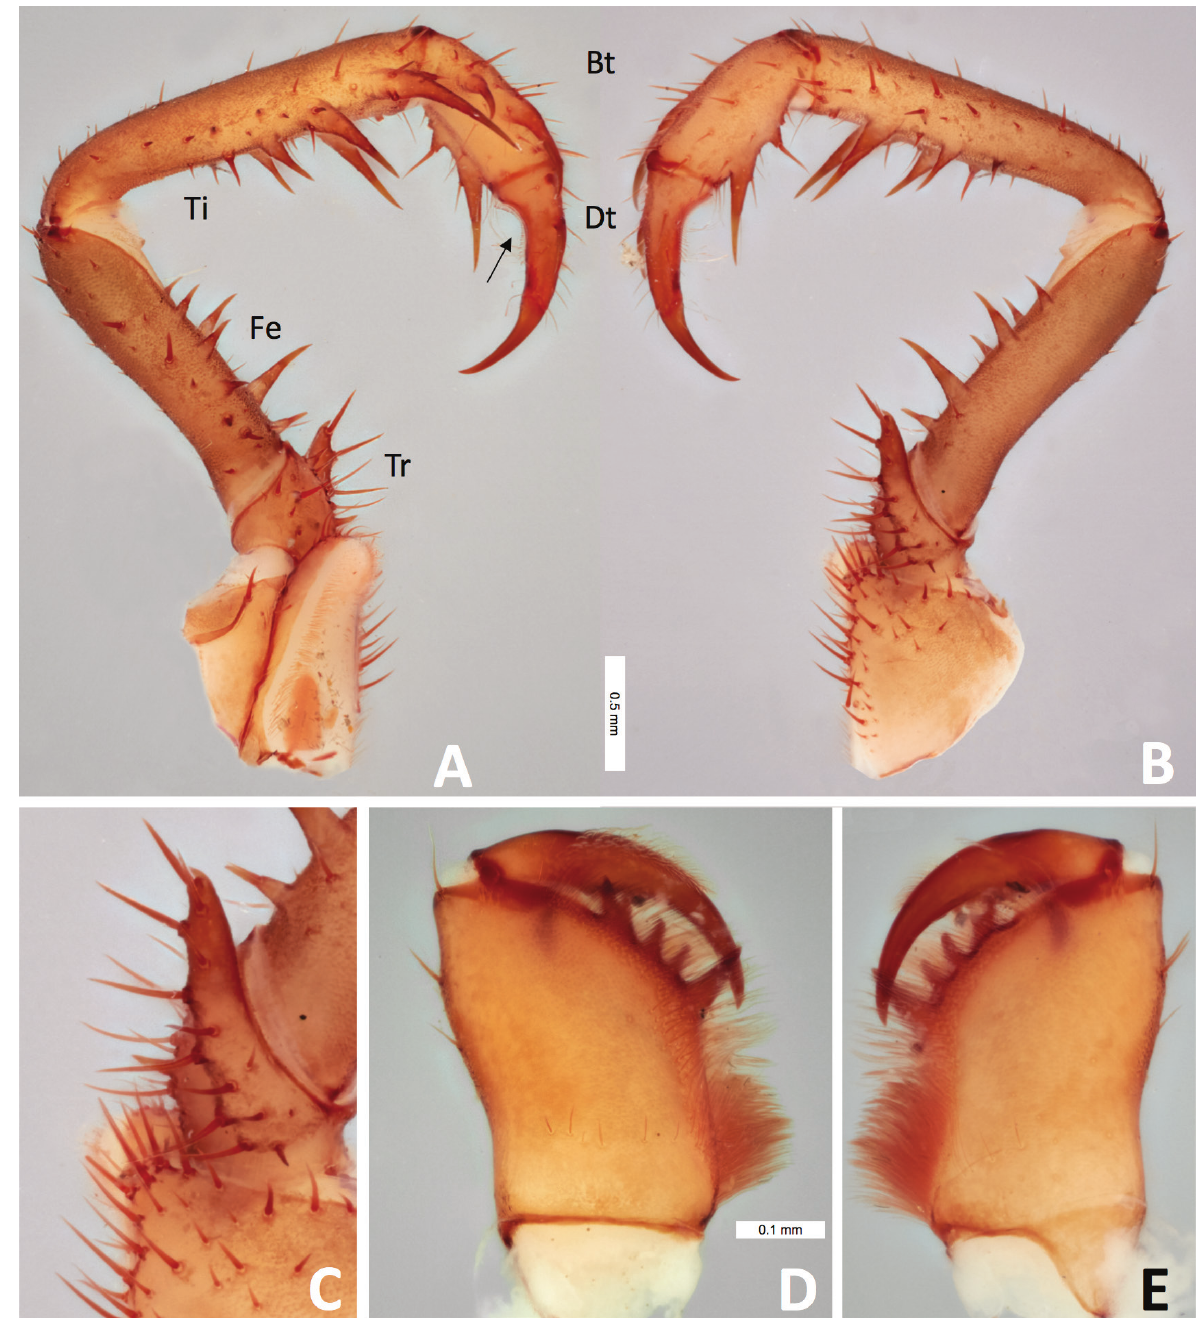
Figure 4. Female holotype of Charinus kakum sp. n.: A , left pedipalp in prolateral view. Arrow points to the position of the cleaning organ; B , left pedipalp in retrolateral view; C , ventral spiniform apophysis, retrolateral view; D , right chelicera in retrolateral view; E , same in prolateral